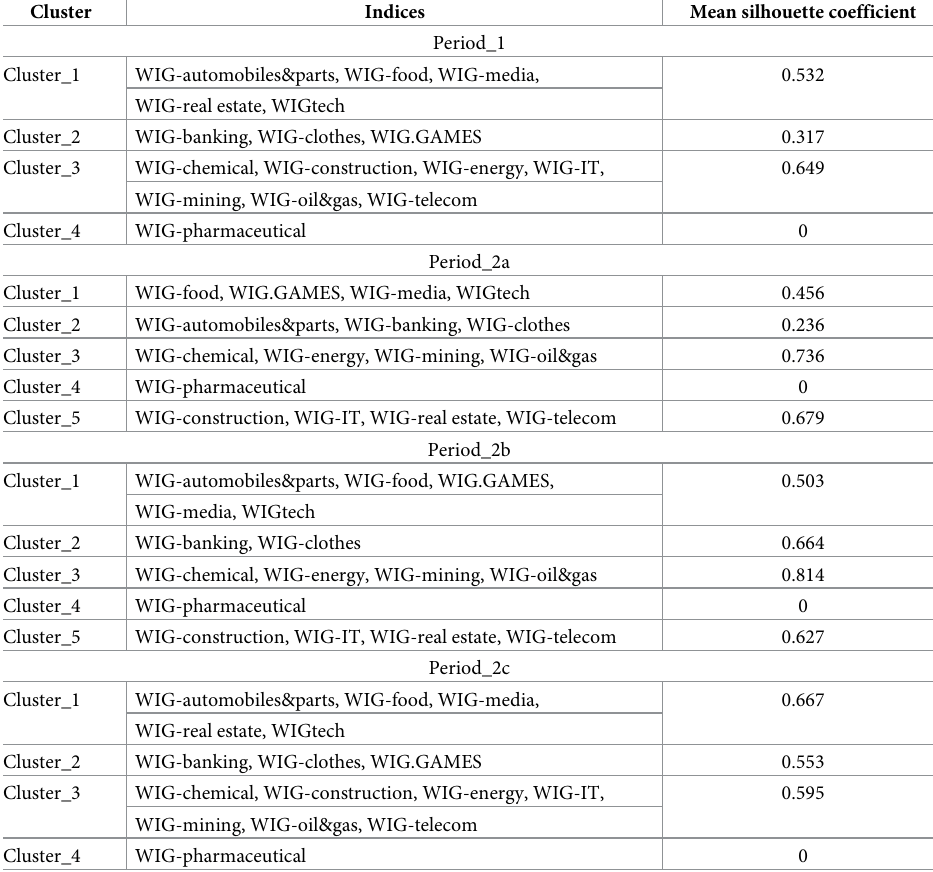
Table 8. Composition of clusters in the investigated periods and their mean silhouette